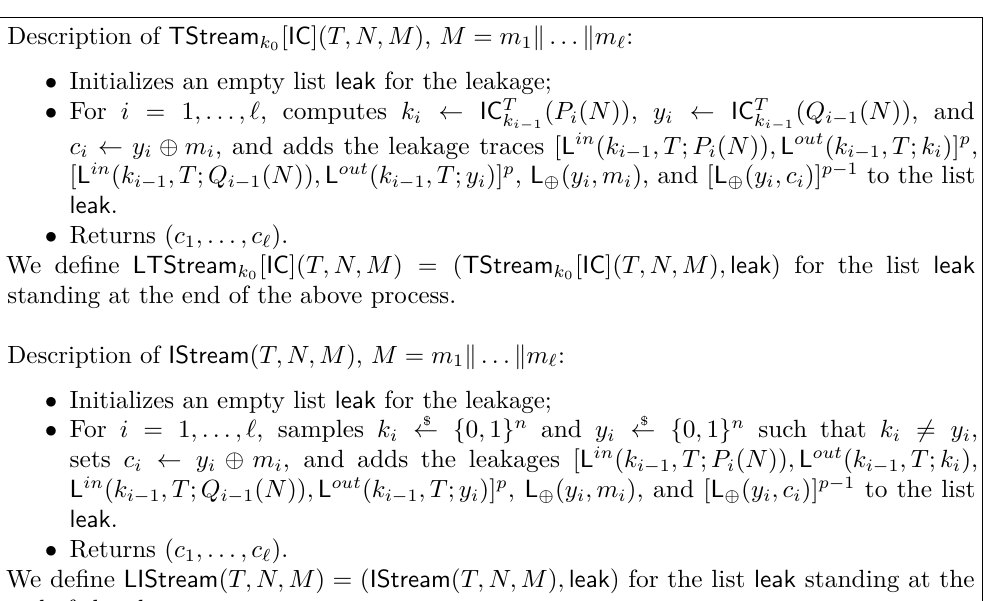
[ IC ] and its ideal counterpart IStream 0